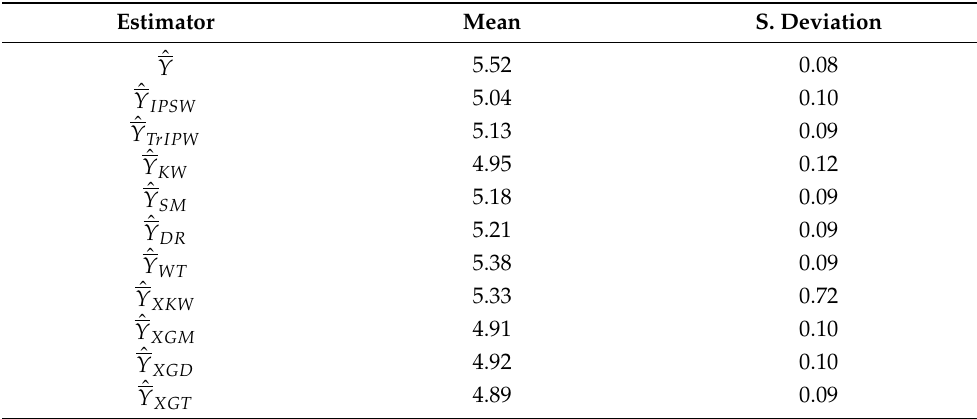
Table 6. Estimates of the population mean of the variable measuring the rating (1–10) of the Spanish government action to control the COVID-19